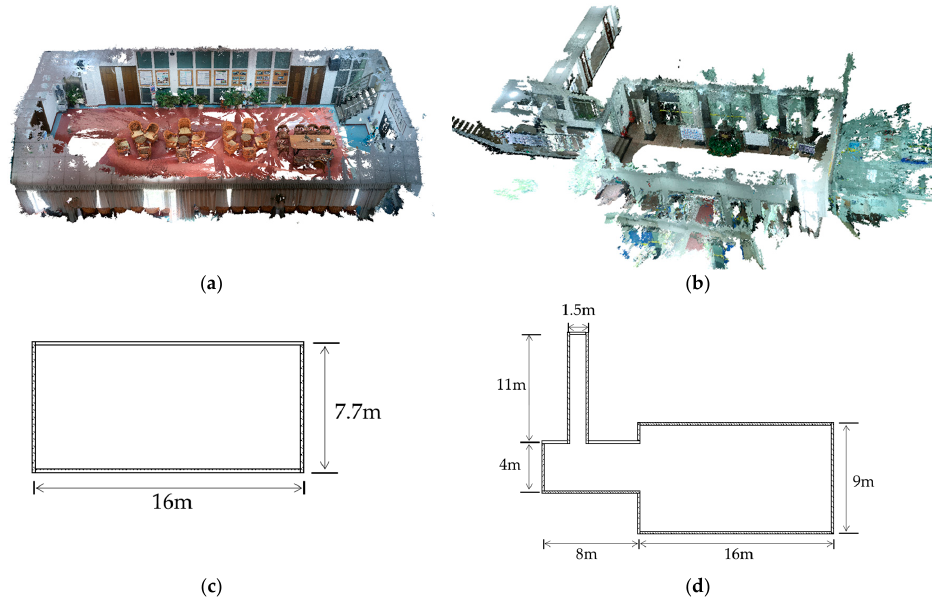
Figure 5. The dense 3D models of the reconstructed datasets. ( a ) A model of the meeting room dataset; ( b ) A model of the lobby dataset; ( c ) The floor plan of the meeting room dataset; ( d ) The floorplan of the lobby dataset.